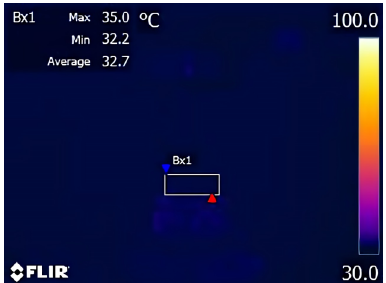
Figure 10. Infrared image during grinding.